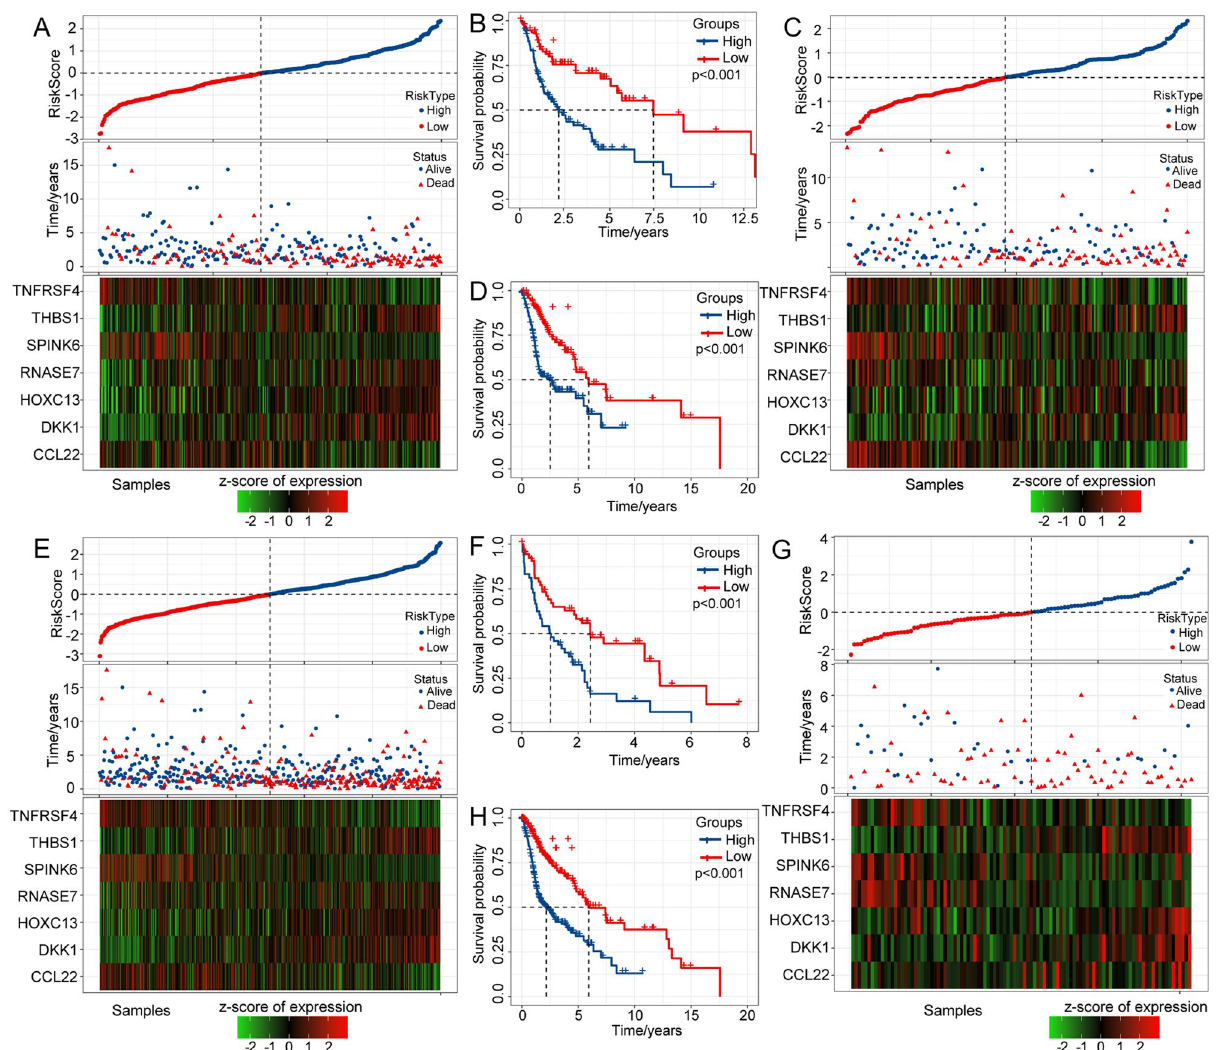
Figure 6. Construction and validation of a prognostic risk model based on DEGs between hypoxia-immune